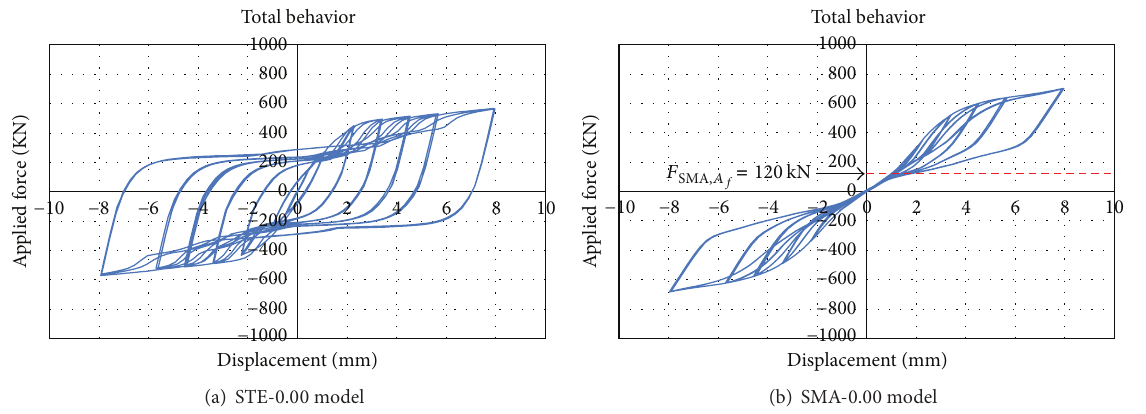
Figure 9: Total behavior of the bearing systems without friction